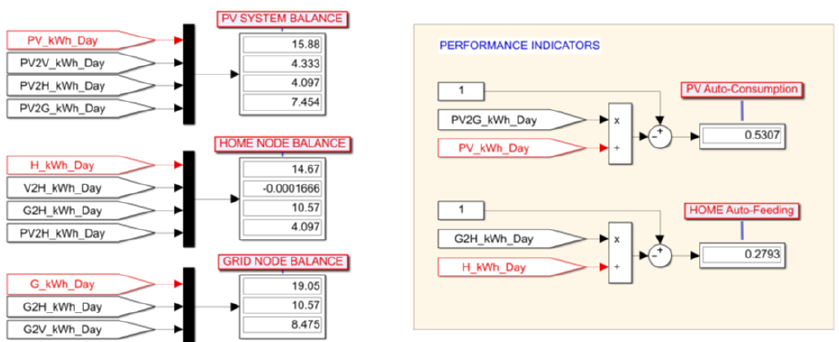
Figure 18. Energy balances at the main nodes ( left ) and performance indicators ( right ) for Case2A — SW 1D.